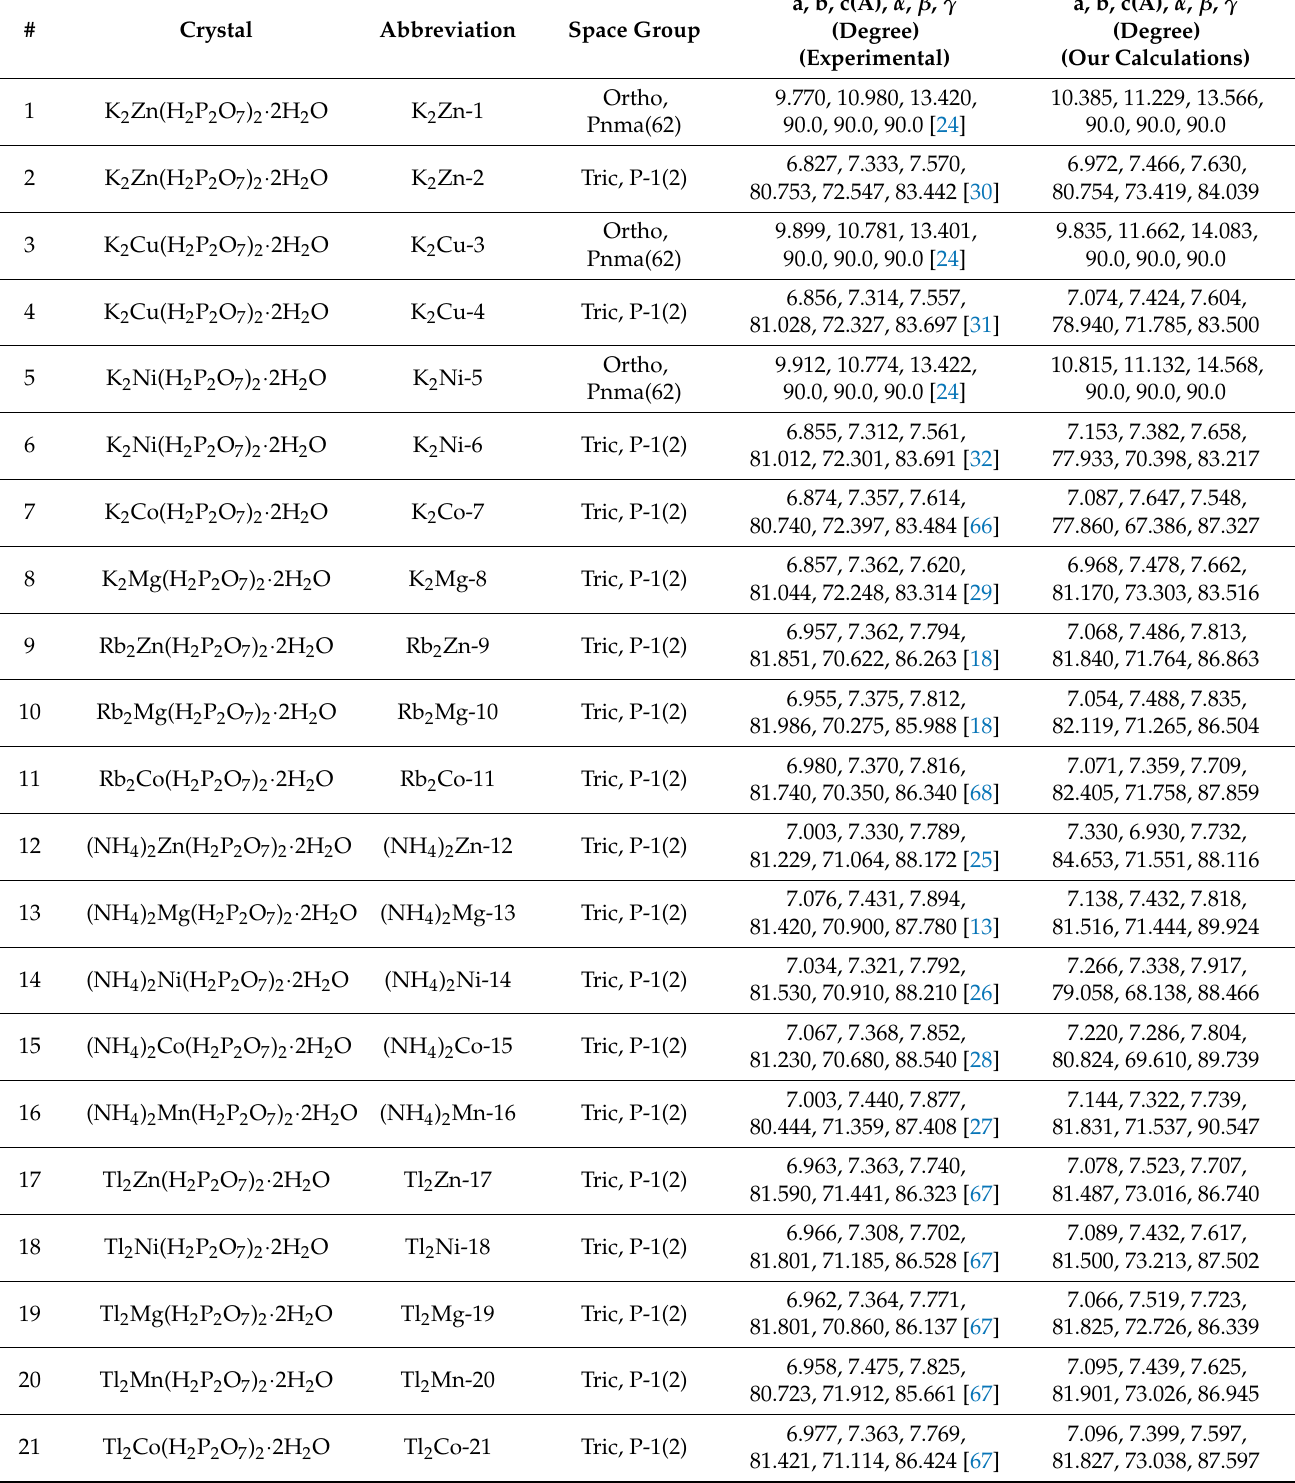
Table 1. Experimental and calculated lattice parameters for the 21